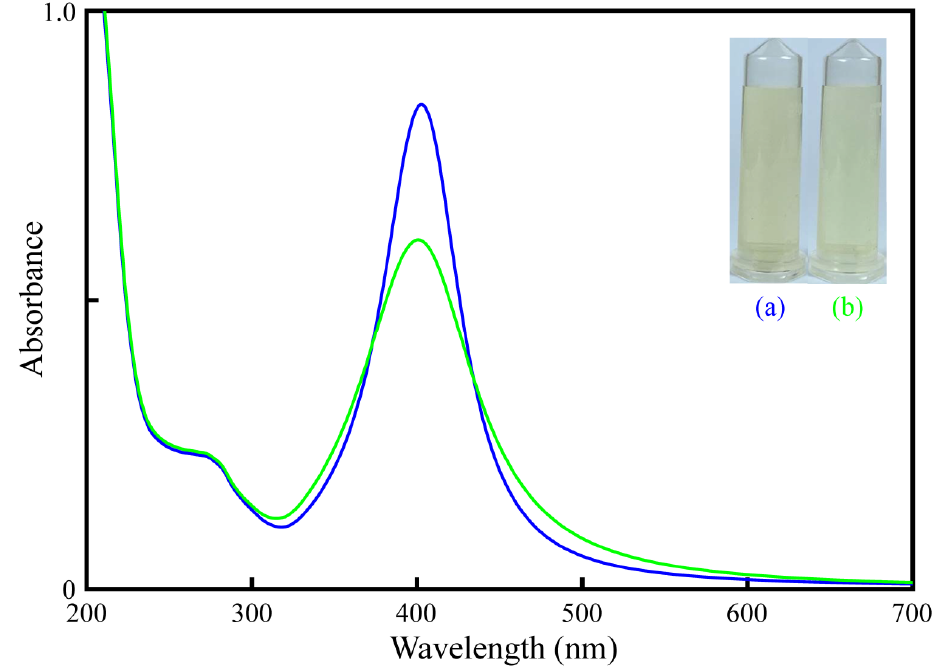
Figure 1. UV–vis spectra of SA-AgNPs solution (blue line) and SA-AgNPs with 10 ppm dimethoate (green line). Inset: corresponding images of (a) SA-AgNPs and (b) SA-AgNPs with dimethoate.